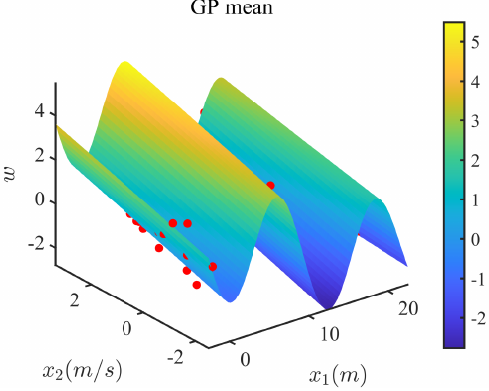
Figure 4. Gaussian process mean, kernel = Square exponent.